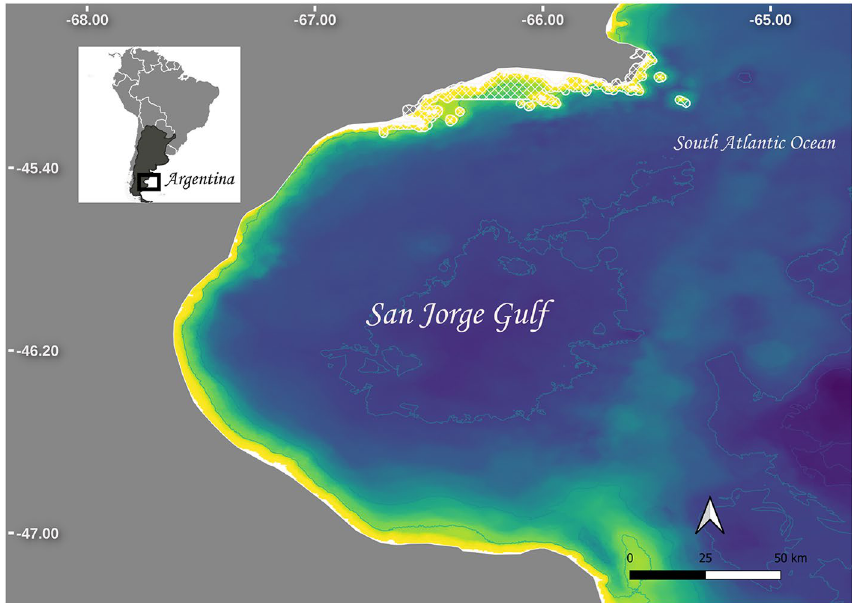
Figure 1. Study site location in Patagonia Argentina, South Atlantic Sea. Marine protected Area, “Patagonia Austral”, is marked in white. Map genereted with QGIS version 3.24.2 ‘Tisler’ from https:// qgis.